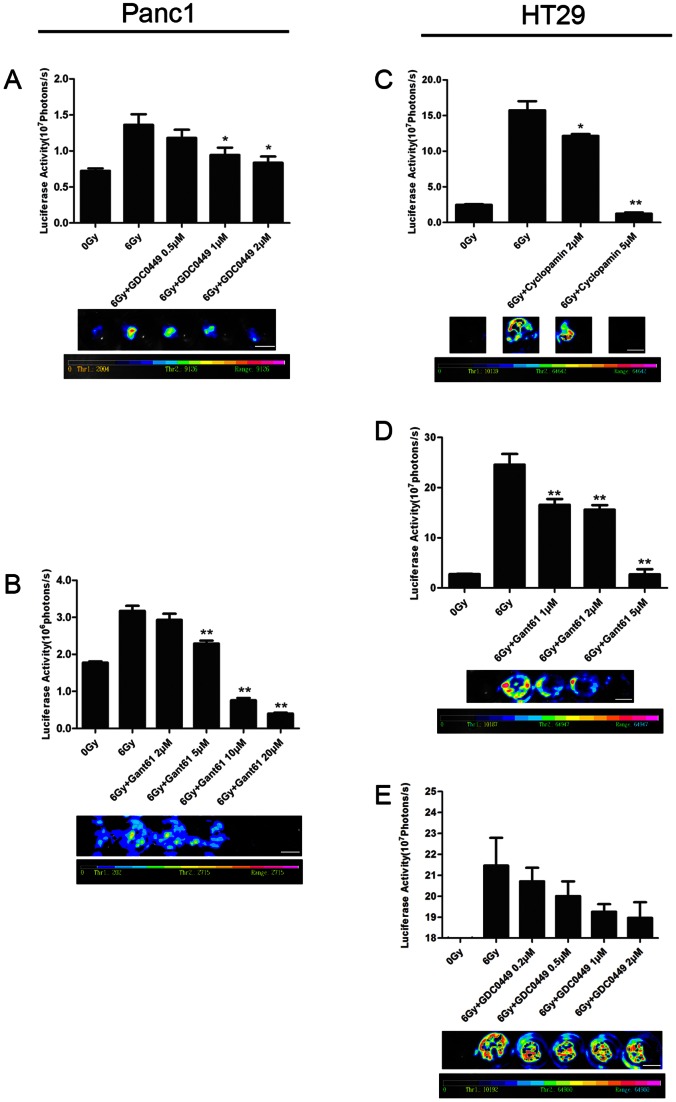
Effects of SHH signaling antagonists on dying cell induced tumor cell repopulation.A. GDC0449, a preclinical SHH pathway inhibitor, inhibits Panc1Fluc cell growth induced by dying Panc1 cell in a dose-dependent manner. Top: signal intensity analysis from bioluminescence image; Bottom: representative bioluminescence images; scale bar represents 1 cm. *represents P<0.05. B. Gant61 inhibits Panc1Fluc cells growth induced by dying Panc1 cells in a dose-dependent manner. Top: signal intensity analysis from bioluminescence image; Bottom: representative bioluminescence images; scale bar represents 1 cm. **represents P<0.01. C. Cyclopamin inhibits HT29Fluc cell growth induced by dying HT29 cells in a dose-dependent manner. Top: signal intensity analysis from bioluminescence image; Bottom: representative bioluminescence images; scale bar represents 1 cm. *represents P<0.05, **represents P<0.01. D. Gant61 inhibits HT29Fluc cell growth induced by dying HT29 cells in a dose-dependent manner. Top: signal intensity analysis from bioluminescence image; Bottom: representative bioluminescence images; scale bar represents 1 cm. **represents P<0.01. E. GDC0449 inhibits HT29 Fluc cell growth induced by dying HT29 cells in a dose-dependent manner. Top: signal intensity analysis from bioluminescence image; Bottom: representative bioluminescence images; scale bar represents 1 cm.